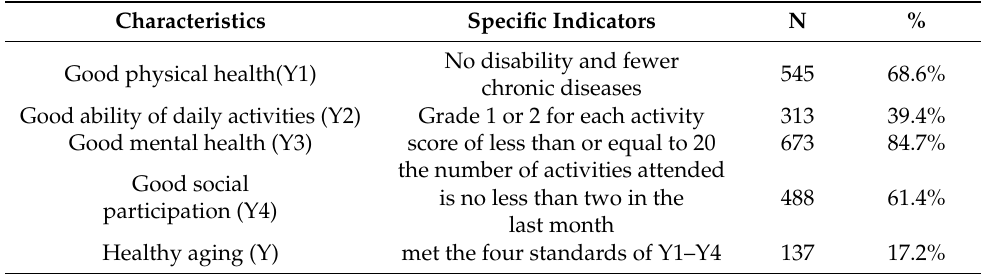
Table 1. Descriptive statistics of dependent